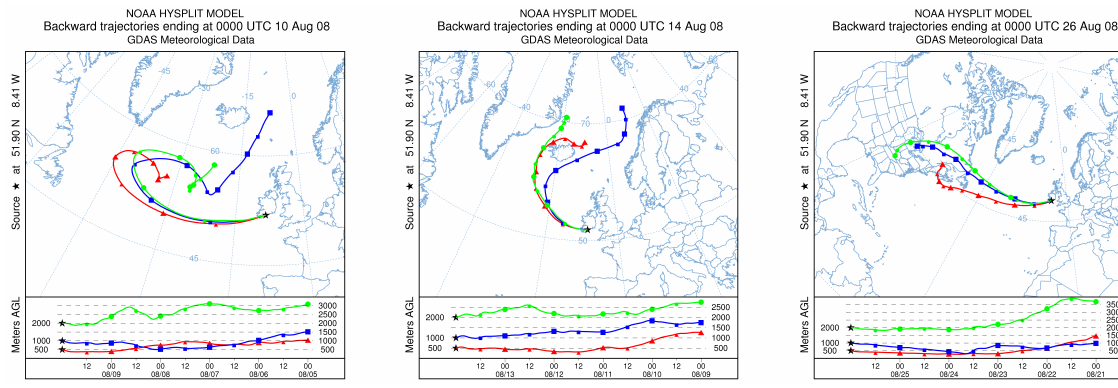
Fig. 15. 5 day back-trajectories for air masses arriving at Cork Harbour at 00:00 on 10 (left), 14 (middle) and 26 August 2008 (right).